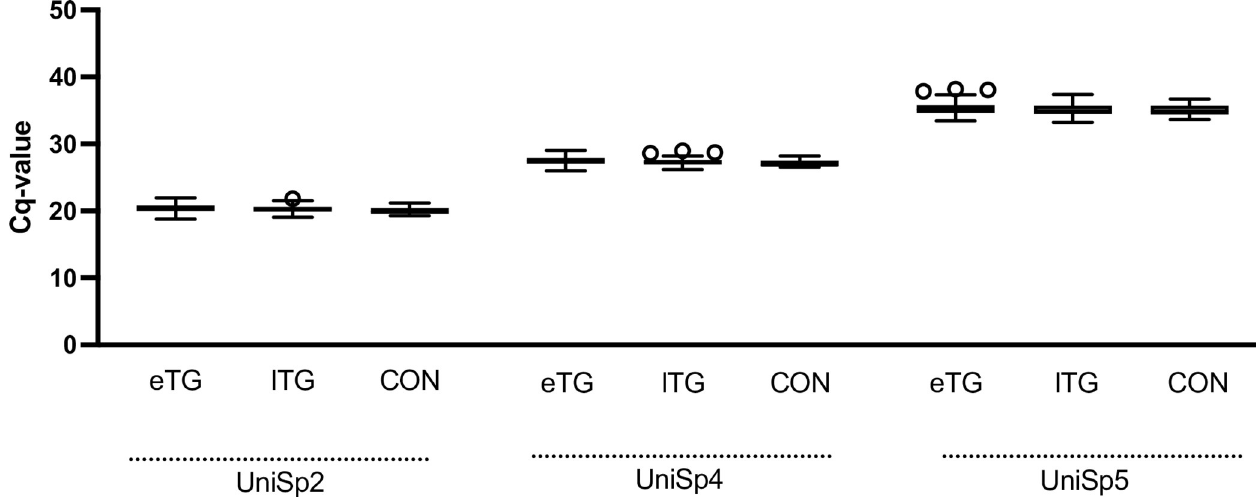
Fig 3. Effect of prophylactic tinzaparin treatment on RNA extraction from plasma. Cq values for three synthetic spike-in RNAs added to plasma prior to RNA extraction; UniSp2 ETG n = 71, LTG n = 57, CON n = 14; UniSp4, ETG n = 71, LTG n = 57, CON n = 14 & UniSp5, ETG N = 69, LTG n = 56, CON n = 14. ETG = early tinzaparin group, LTG = late tinzaparin group, CON = control. The horizontal line shows the median, while the box encompasses the 50th percentile and the whiskers encompass the minimum and maximum values. Outliers are displayed as points. Outliers are defined according to Tukey, as values exceeding more than the 75 percentile plus 1.5 IQR. Multiple comparisons showed a significant difference between ETG and CON, p = 0.017, denoted by � .